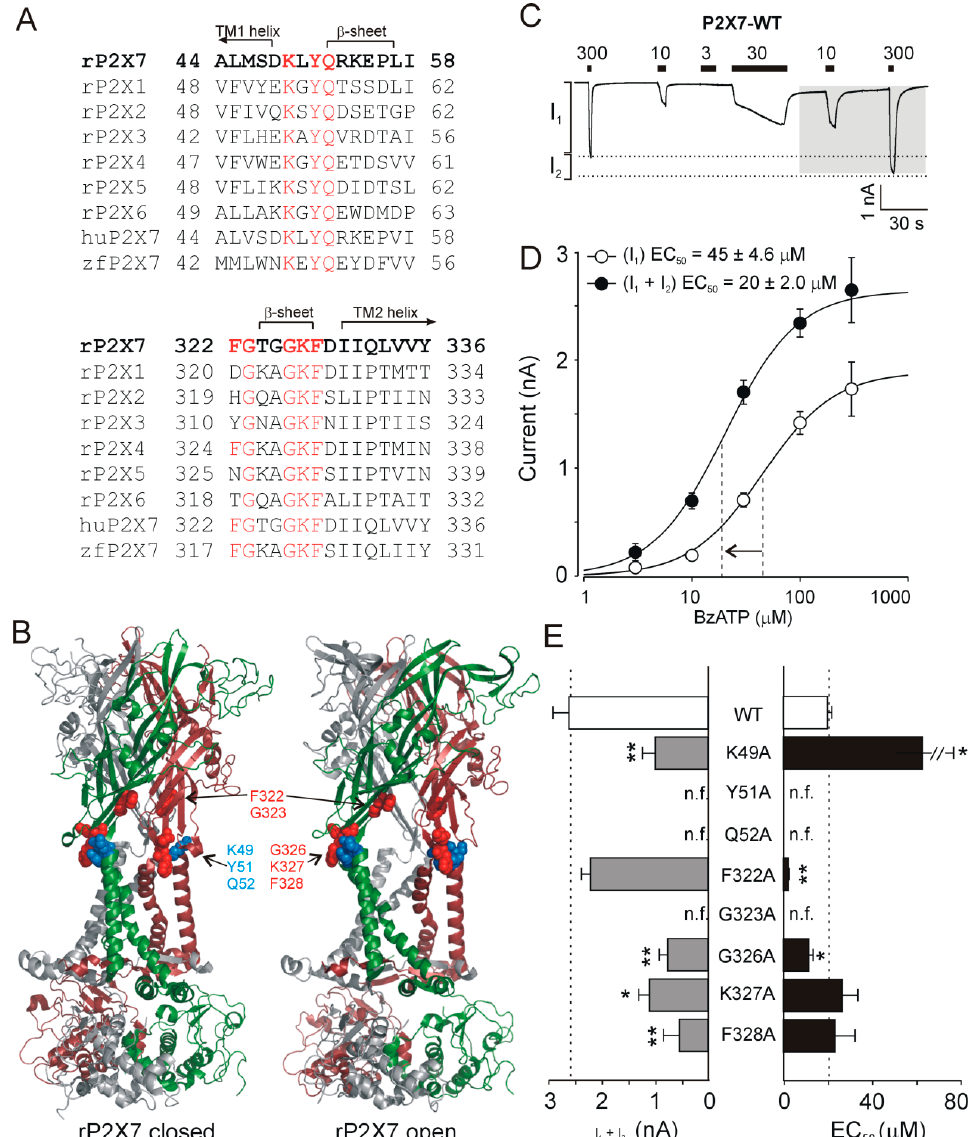
Figure 1. Effect of alanine point mutations of conserved and unique residues in the extracellular vestibule on rat P2X7 (rP2X7) activity. ( A ) Alignment of amino acid sequences A44–I58 and F322–Y336 (rP2X7 numbering) forming extracellular vestibules in seven rat P2X receptors (rP2X1–7), the human P2X7 receptor (huP2X7), and the zebrafish P2X7 receptor (zfP2X7). These regions are composed of extracellularly oriented parts of transmembrane domains (TM1and TM2) α -helices, random coils, and β -sheets. Conserved and unique residues examined in this study are shown in red. ( B ) The topology of conserved and unique residues in the extracellular vestibule of rP2X7 in the apo-closed state (left) and ATP-bound open state (right). The three subunits of the trimeric receptor are shown in green, purple, and gray, and the mutated residues adjacent to the TM1 and TM2 helices are shown as blue and red spheres, respectively. The figure was generated using models of full-length rP2X7 in the apo-closed (PDB ID: 6U9V) and ATP-bound open (PDB ID: 6U9W) states [31] and PyMOL v0.99 (http: // www.pymol.org). ( C ) Example recording showing the responses of human embryonic